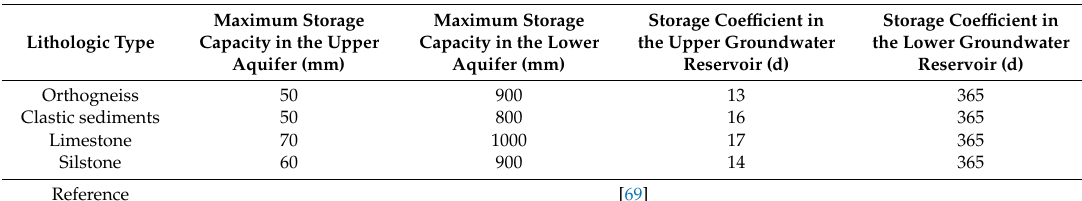
Table 4. Lithologic parameters used in the hydrologic